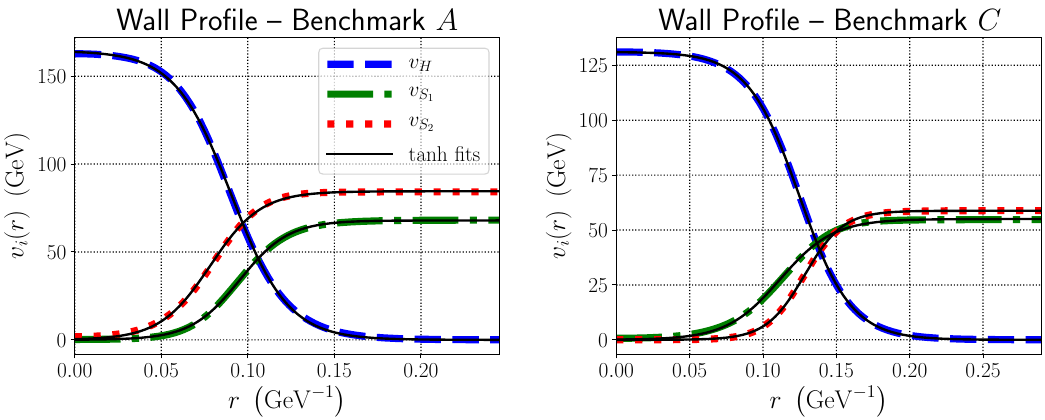
Figure 5. The radial nucleation bubble wall VEV profiles of the electroweak phase transition for benchmark points A and C . r = 0 is the centre of the bubble. The thin black lines are fitted hyperbolic tangent functions, eq. (4.10). The profiles for benchmarks B and D are approximately equivalent to those of A and C , respectively.